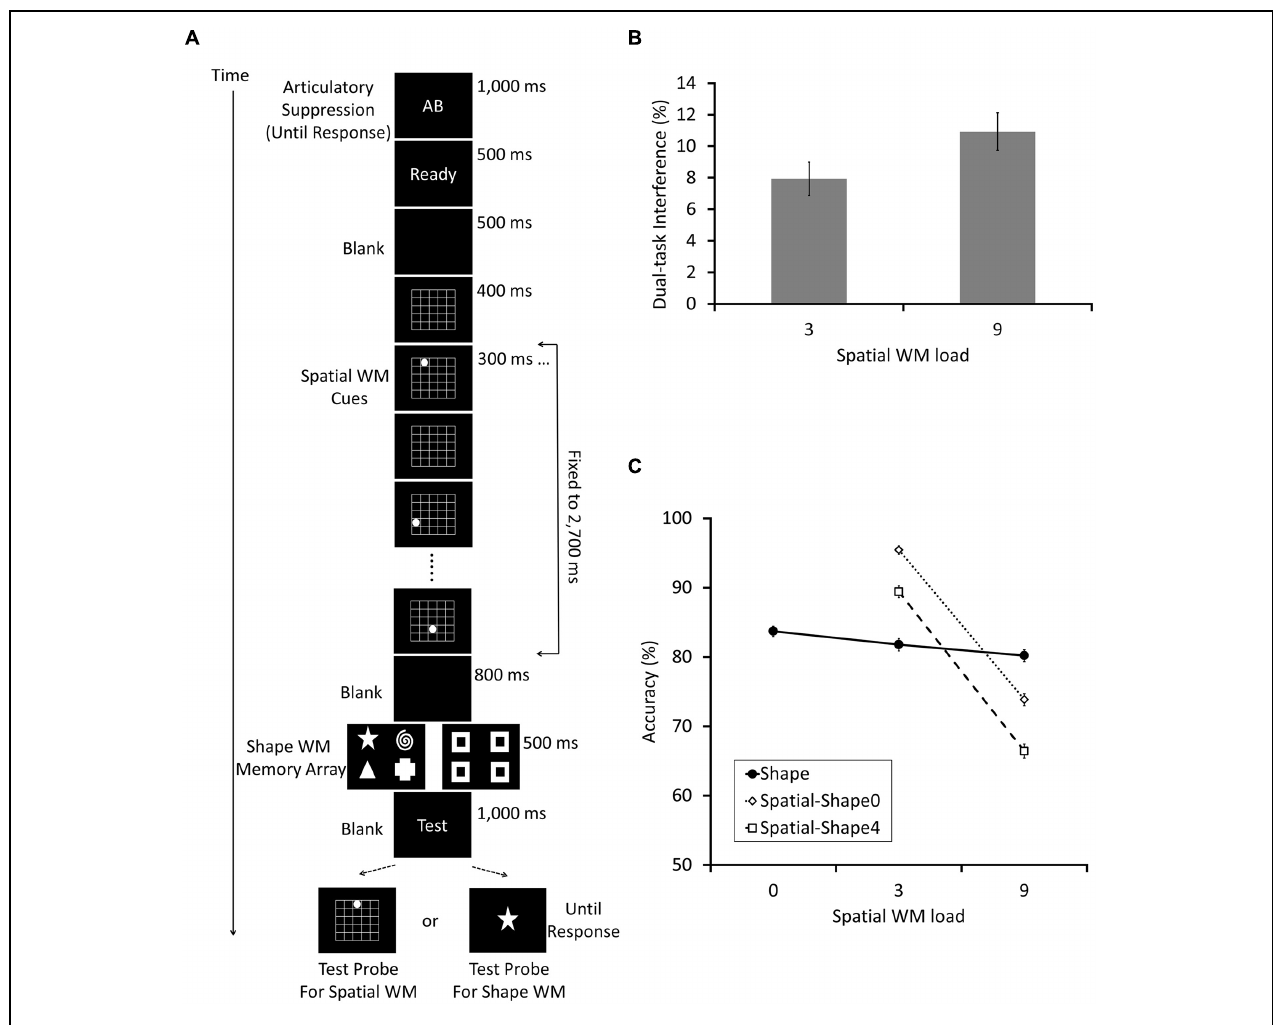
FIGURE 5 | The experimental procedure (A) and results (B,C) for Experiment 4, which was an exact replication of Experiment 2 of Wood (2011), except that the spatial cue presentation was conducted sequentially instead of simultaneously. The load size of spatial WM randomly changed from 0, 3, to 5, and that of the shape were also manipulated (0 and 4) randomly. (B) Depicts the “combined dual task interference” scores, which were calculated following Wood (2011; see text for the details), as a